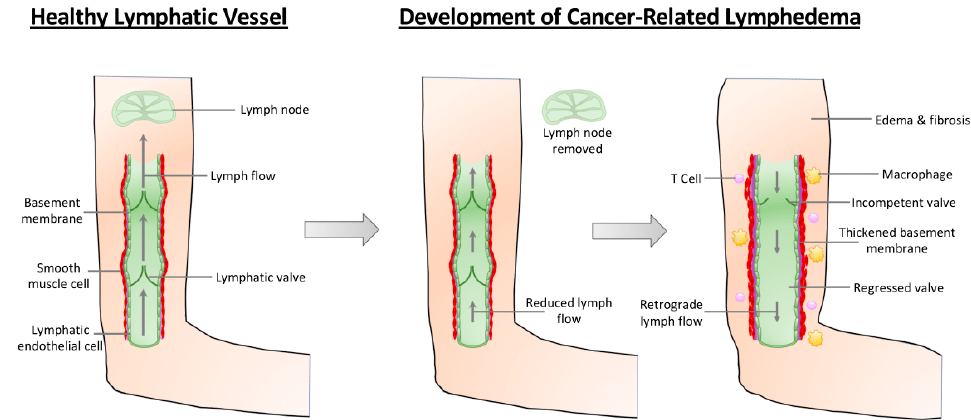
Figure 1. Pathological changes in the arm during the development of cancer-related lymphedema. In a healthy lymphatic vasculature (leftmost panel), valves prevent the retrograde flow of lymph, ensuring its efficient transport from the lymphatic capillaries to the lymph node. Following surgical intervention as part of cancer therapy, some patients will develop cancer-related lymphedema. Lymph node removal surgery reduces the flow of lymph through the lymphatic vasculature (middle panel). Over time, however, collecting lymphatic vessels exhibit increased inflammation, thickened basement membrane, increased smooth muscle cell coverage, and dilation (right panel). Reduced lymph flow results in reduced VE-cadherin-dependent mechanotransduction signaling that reduces the expression of transcription factors required for valve maintenance, leading to valve regression. Consequently, lymph flow moves in the retrograde direction and fluid is no longer transported out of the tissue, resulting in lymphedema and